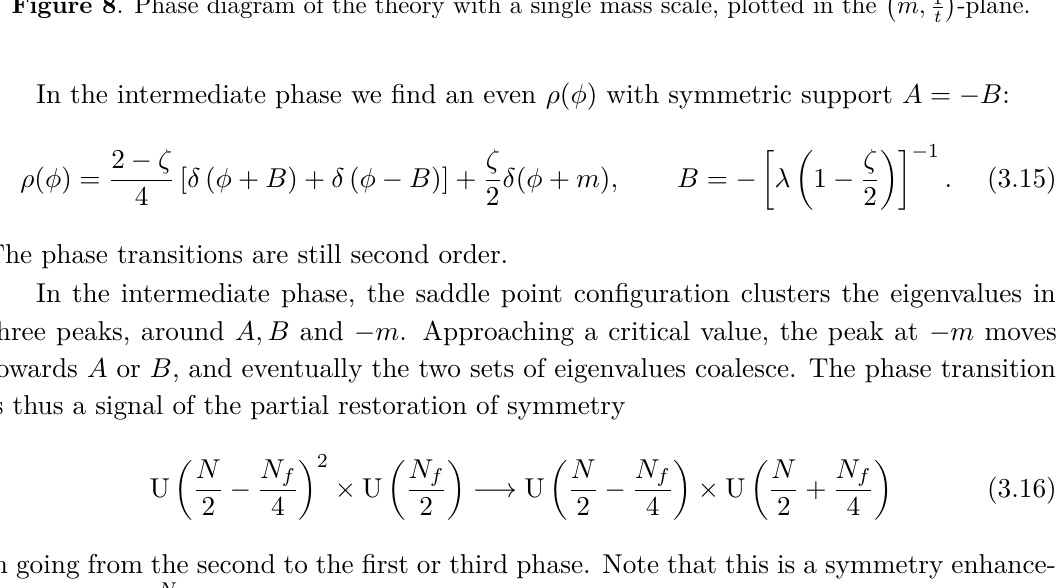
Figure 8 . Phase diagram of the theory with a single mass scale, plotted in the